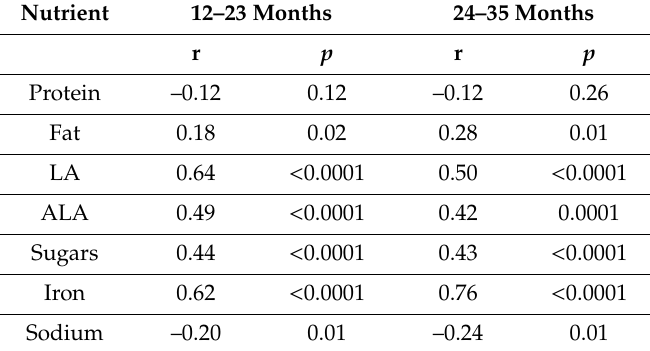
Table 6. Relationship between daily intake of YCF and daily nutrient intake (Pearson correlation coe ffi cient, r).